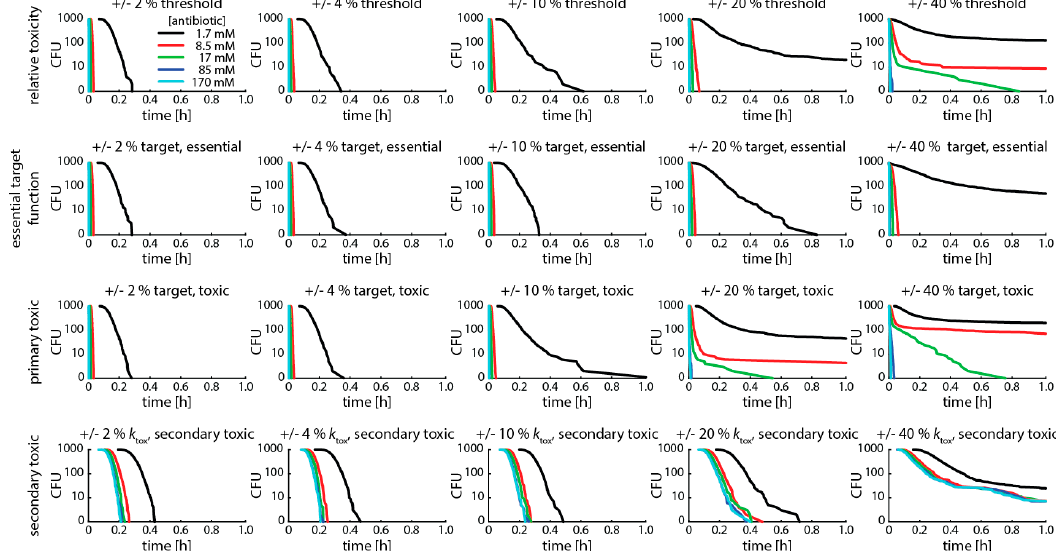
Figure A2. Variances in binding kinetics of any step causing bacterial killing leads to multiphasic kill curves. This graph shows simulations with the same parameter set as Figure 5, but different variances in bacterial populations. We show Gillespie simulations of four different scenarios of bacterial killing (see explanation in text) and different degrees of variance (columns). In all simulations, we assume i) 100 target molecules, ii) a binding rate k f of 1.2 × 10 6 M -1 s -1 , iii) an unbinding rate k r of 1.2 × 10 -3 (for rifampicin, [25]), and iv) an intracellular volume of 10 -15 . We vary the antibiotic concentration from 1.7 (black), 8.5 (red), 17 (green), 85 (blue) to 170 (turquoise) mM. The top panel shows the “relative toxicity” scenario. Threshold for killing 50%, threshold normally distributed with standard deviation (SD) given in graph. The second panel shows the “essential target function” scenario. Threshold for killing 50 free target molecules, target number normally distributed with SD given in the graph. The third panel shows the “primary toxic” scenario. Threshold for killing 50 bound target molecules, target number normally distributed with SD given in the graph. The bottom panel shows the “secondary toxic” scenario. Threshold for killing 500 accumulated toxic metabolites, rate of metabolite production k tox is 1.2 × 10 6 M -1 s -1 , k tox is normally distributed with SD given in the graph.